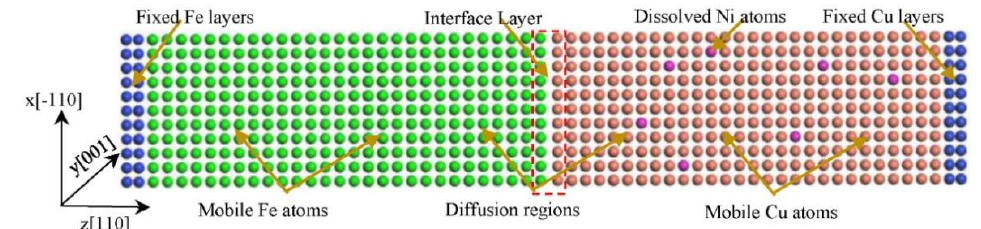
Figure 1. Atomic distribution diagrammatic sketch of the initial Fe/Cu model. The nickel atoms are distributed in the Cu mobile region.